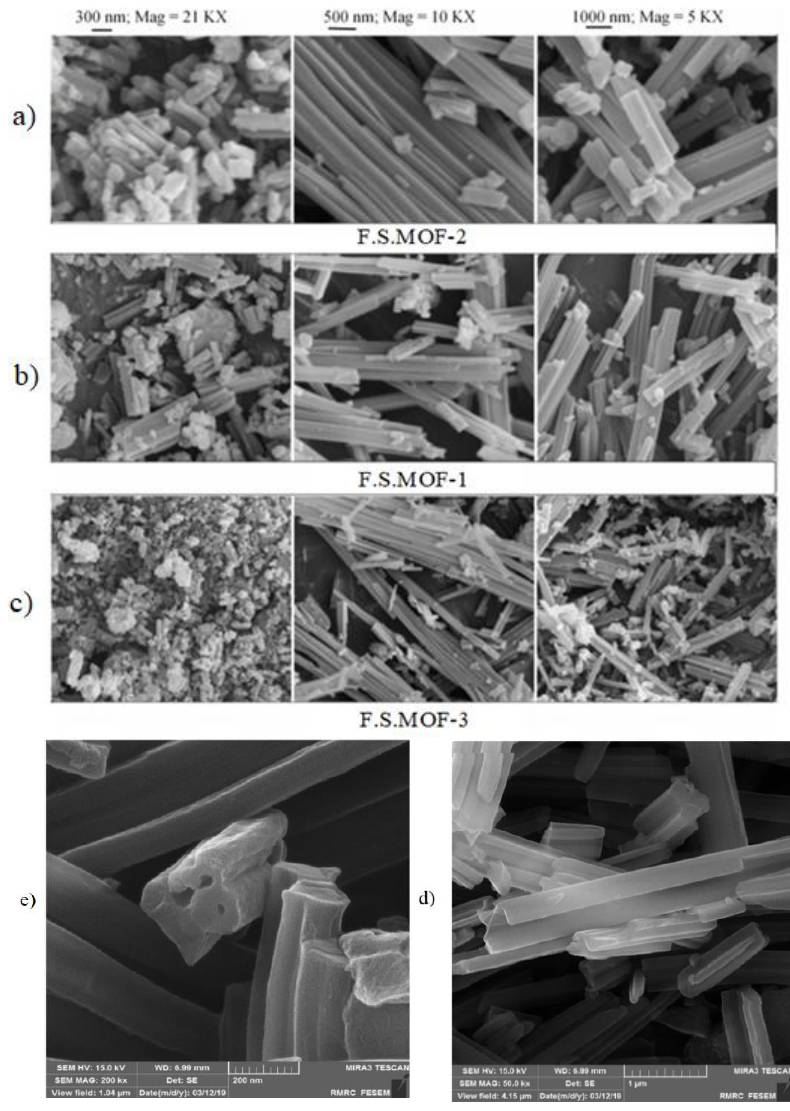
Fig. 7. SEM image of synthesized NiFe O @SiO @HKUST-1 metal-organic 2 4 2 c) 50% d) close view, e) cross section view.